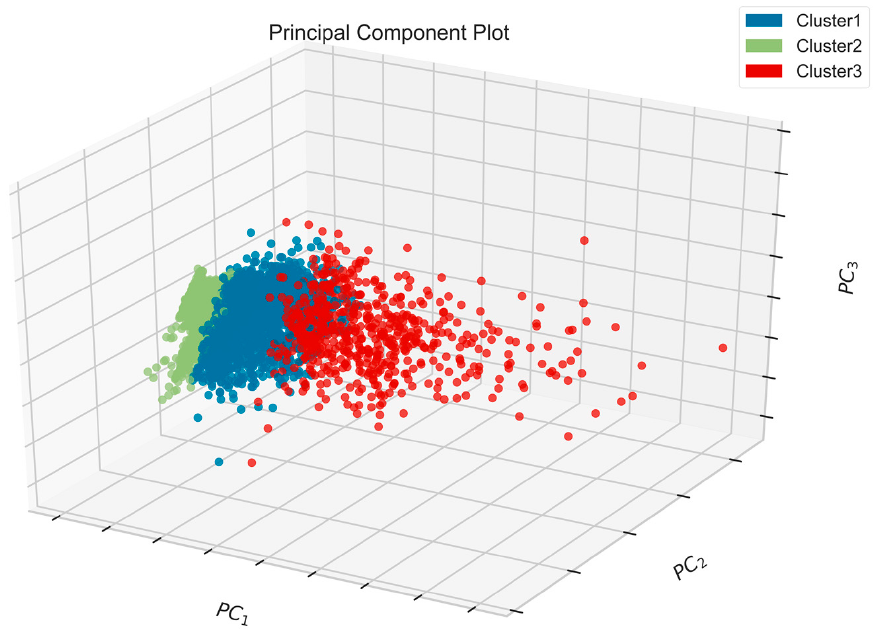
Figure 11. Clustering result with FCM applied when c is set to 3.